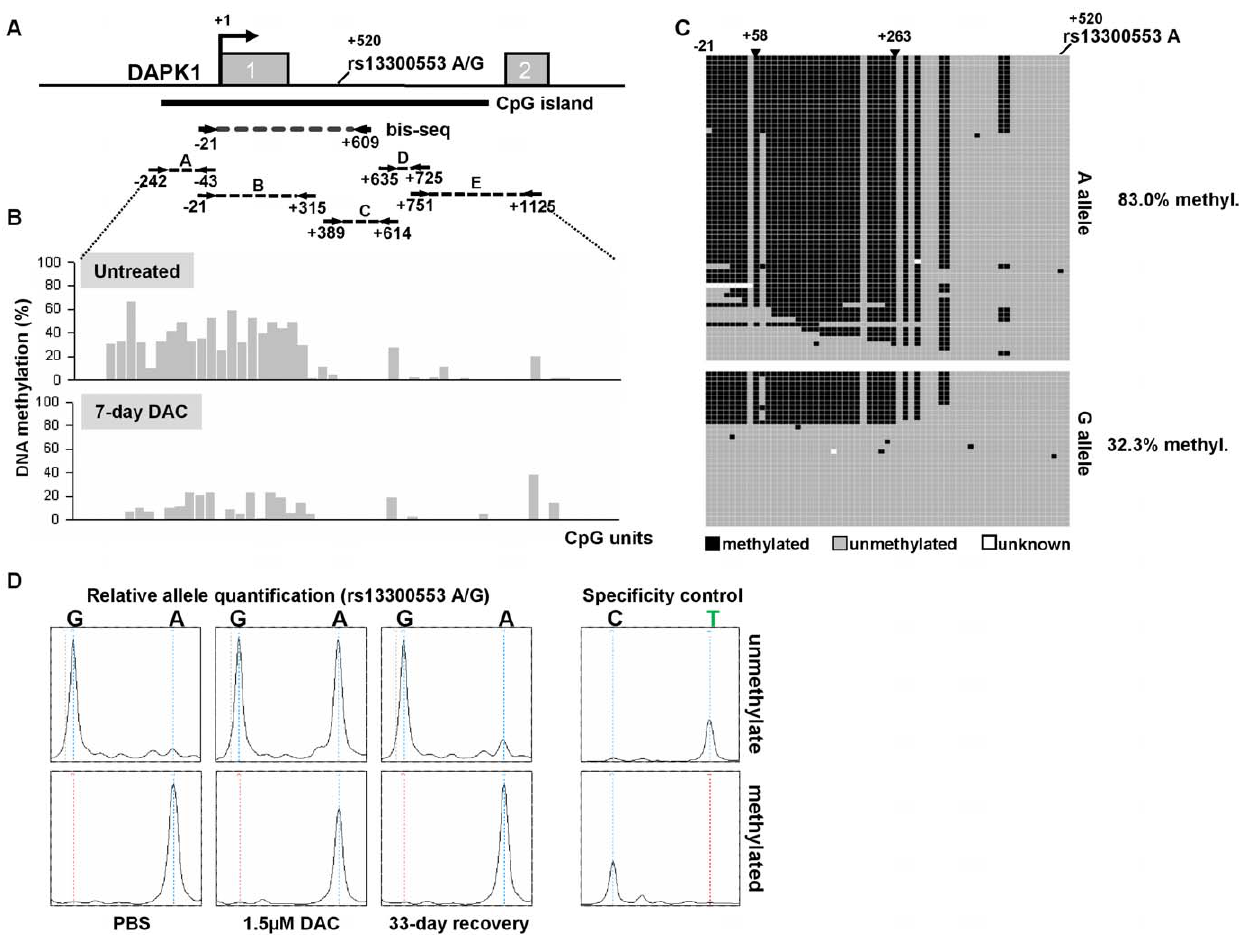
Figure 4. Allele-specific DNA methylation (ASM) contributes to ASE of DAPK1 in Granta-519 cells. (A) Scheme of the DAPK1 promoter region and the associated CpG island. Grey boxes display the first 2 exons of DAPK1 . Nucleotide positions are given relative to DAPK1 transcriptional start site (TSS). Dashed lines represent positions of the investigated regions/amplicons. (B) Quantitative DNA methylation analysis of the DAPK1 gene 5 9 region (amplicons A–E) in untreated and 5-aza-2 9 -deoxycytidine (DAC)-treated Granta-519 cells was performed using the MassARRAY-based MassCleave method. Bars represent quantitative DNA methylation values (%) at single CpG units. (C) Bisulfite-sequencing of the DAPK1 5 9 region including the SNP rs13300553 (G/A) used for allelic separation in Granta-519 cells. Sequenced clones carrying A at the respective SNP site ( + 520) are grouped in the upper panel, the G alleles are displayed in the lower panel. Black boxes represent single-CpG methylation, grey boxes represent unmethylated CpGs, white boxes stand for missing data. Methylation levels are calculated over the area between + 58 and + 263 in both allele groups. (D) Detection of ASM by separate amplification of either the unmethylated or methylated alleles by methylation-specific PCR on bisulfite-converted genomic DNA. Genotype distribution between the differentially methylated alleles was performed by SNuPE/MALDI-TOF. Untreated Granta-519 (PBS), 7-day treatment with the DNMT inhibitor 5-aza-2 9 -deoxycytidine (DAC), and assessment of ASM after 33 days of withdrawal of DAC (33-day recovery) are shown. The right panel shows the assessment of a CpG dinucleotide as specificity control (see results section for detailed